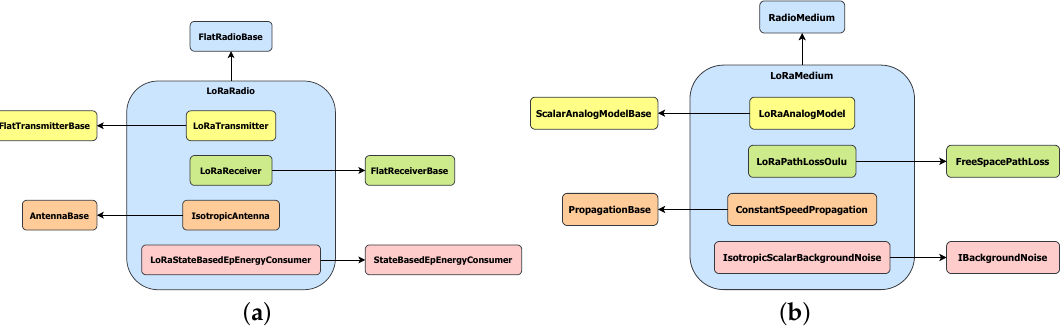
Figure 7. Structure of ( a ) LoRaRadio class and ( b ) LoRaMedium